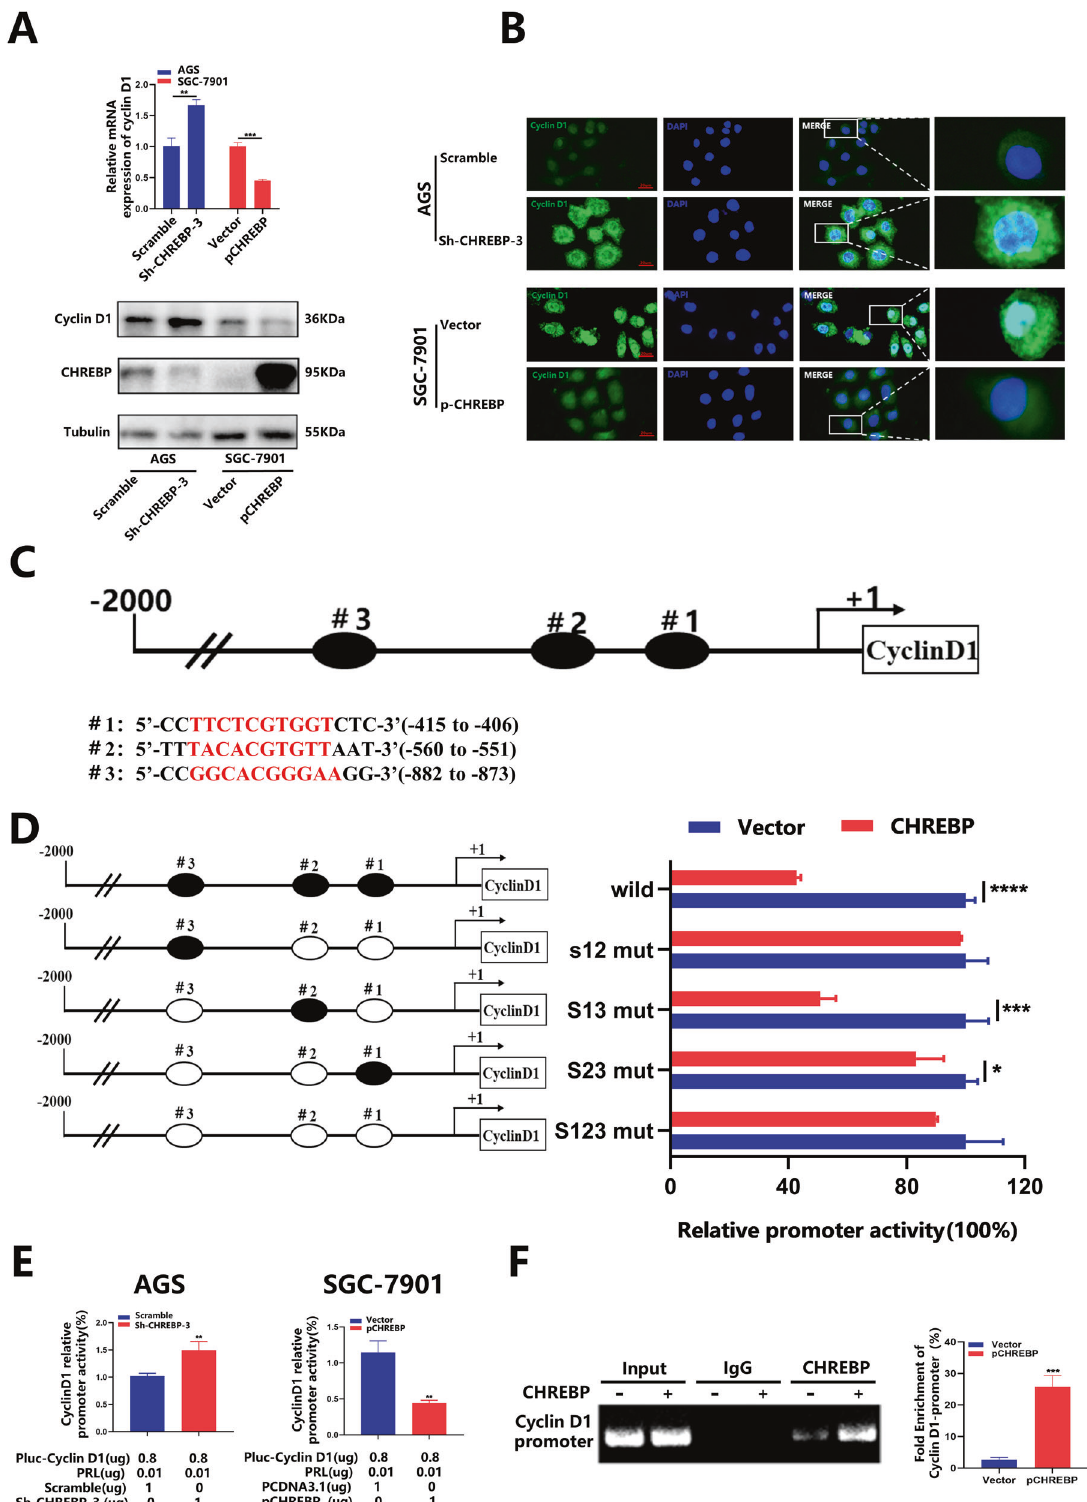
Fig. 5 CHREBP downregulates cyclin D1 levels by binding to its promoters. A qRT – PCR and WB were conducted to detect CHREBP impact on cyclin D1 expression of GC cells. B IF assay was employed to estimate the expression and location of cyclin D1 in GC cells (scale bar: 20 μ m). C The putative binding sites of CHREBP in the promoter region of cyclin D1. D Cyclin D1 promoters were transfected into SGC-7901 cells in triplicate with CHREBP expression or control vectors for 24 h. Cyclin D1 promoter activity was detected using a dual-luciferase reporter assay kit. Relative promoter activity in the treatment group was expressed as a percentage of that in the control group. E The effects of CHREBP on cyclin D1 promoter activity. A dual-luciferase reporter assay revealed that CHREBP could suppress cyclin D1 promoter activity in AGS and SGC- 7901 cells. F CHIP assay and qRT – PCR showed that CHREBP could bind to cyclin D1 promoter region.